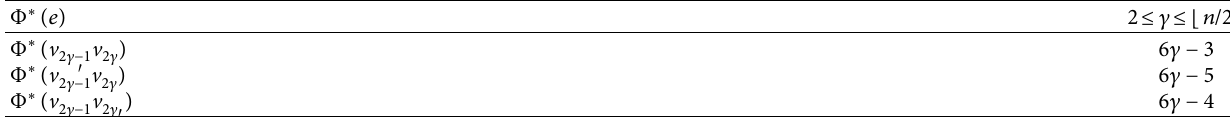
Table 40: Edge labeling of Φ ∗ ( e ) .